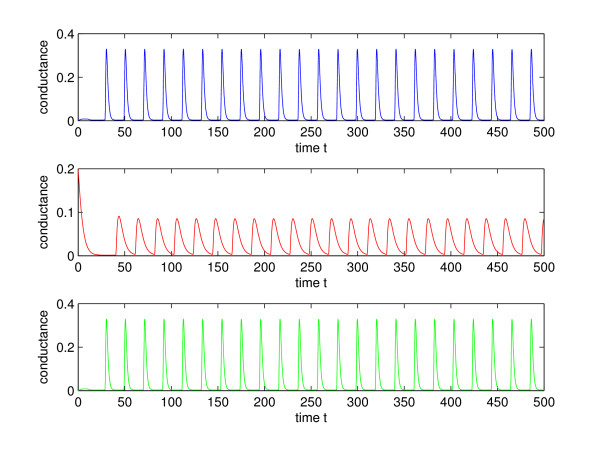
Conductance for τsyn = 1, τsyn2 = 3. All else as in Fig. 4.